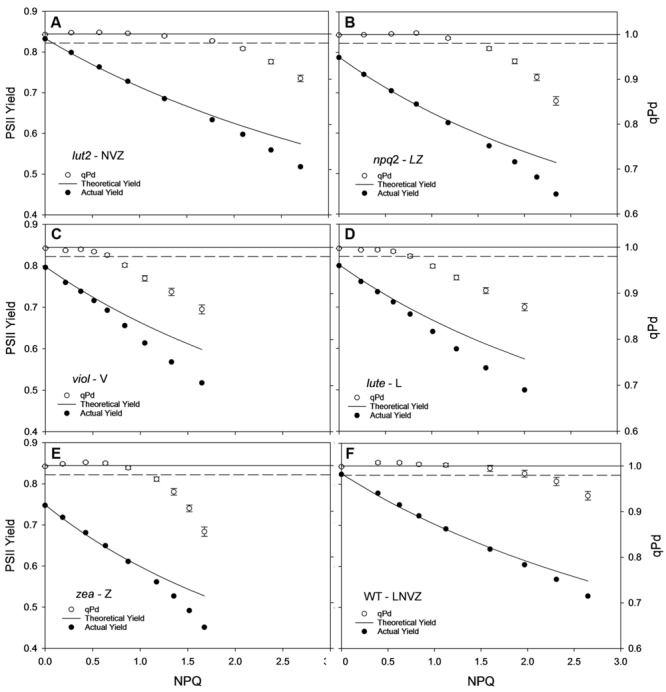
Displays the actual (closed circles) and theoretical (black line) yields of PSII (ΦPSII) in function of NPQ and qPd (open circles, see Materials and Methods) in lut2(A), npq2(B), viol(C), lute(D), zea(E)Arabidopsis mutants and the wild type (F) plants. Data points are the average of 30 repeats conducted on whole intact leaves using the pNPQ assessment procedure (Figure 1A). Error bars represent the standard error of the mean. lut2 – no lutein, npq2 – no violaxanthin and neoxanthin, viol – violaxanthin only, lute – lutein only, zea – zeaxanthin only, WT – wild type. Theoretical PSII yield was calculated as described in Materials and Methods.